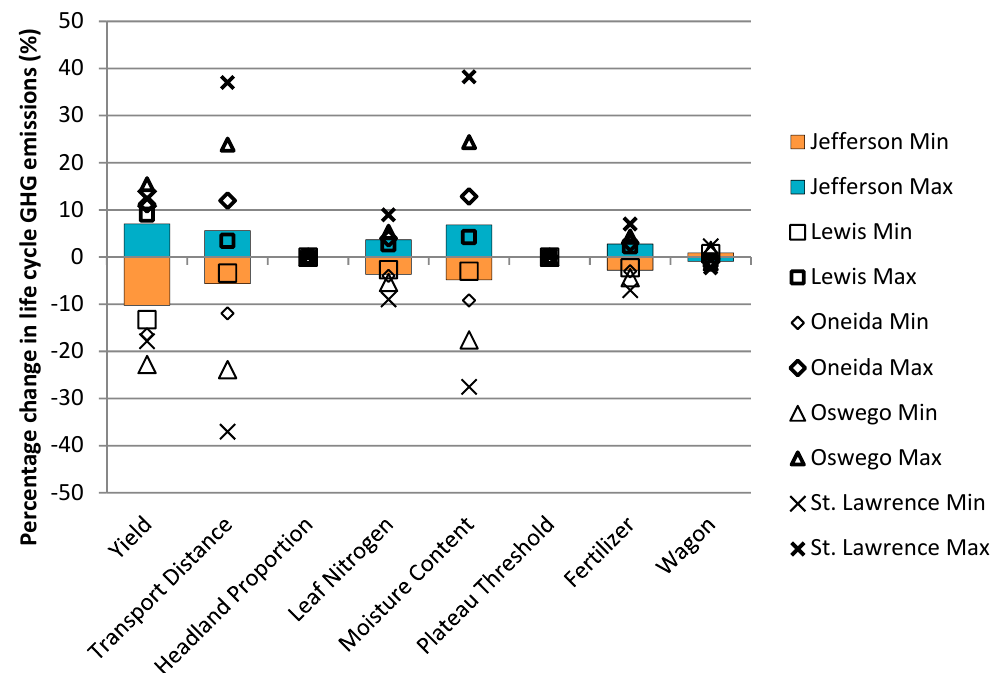
Figure 10. Range of life cycle GHG emissions expressed as the percentage of the baseline life cycle GHG emissions by varying each parameter individually in sensitivity analysis to its minimum (“Min”) or maximum (“Max”) value. Baseline parameter values and their variations are shown in Table 1. Plateau threshold represents threshold harvesting speed value that provides maximum throughput for the harvester.